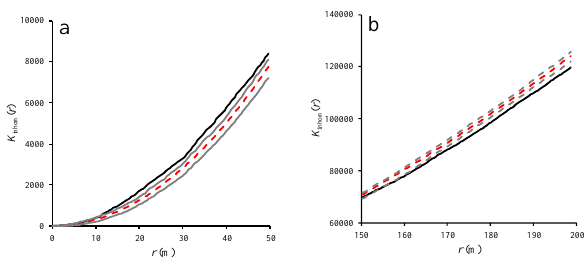
Figure 5. Inhomogeneous K -function at scales of 0-50 m (a) and 150-200 m (b) for heterogeneous pattern of wild pistachio trees.